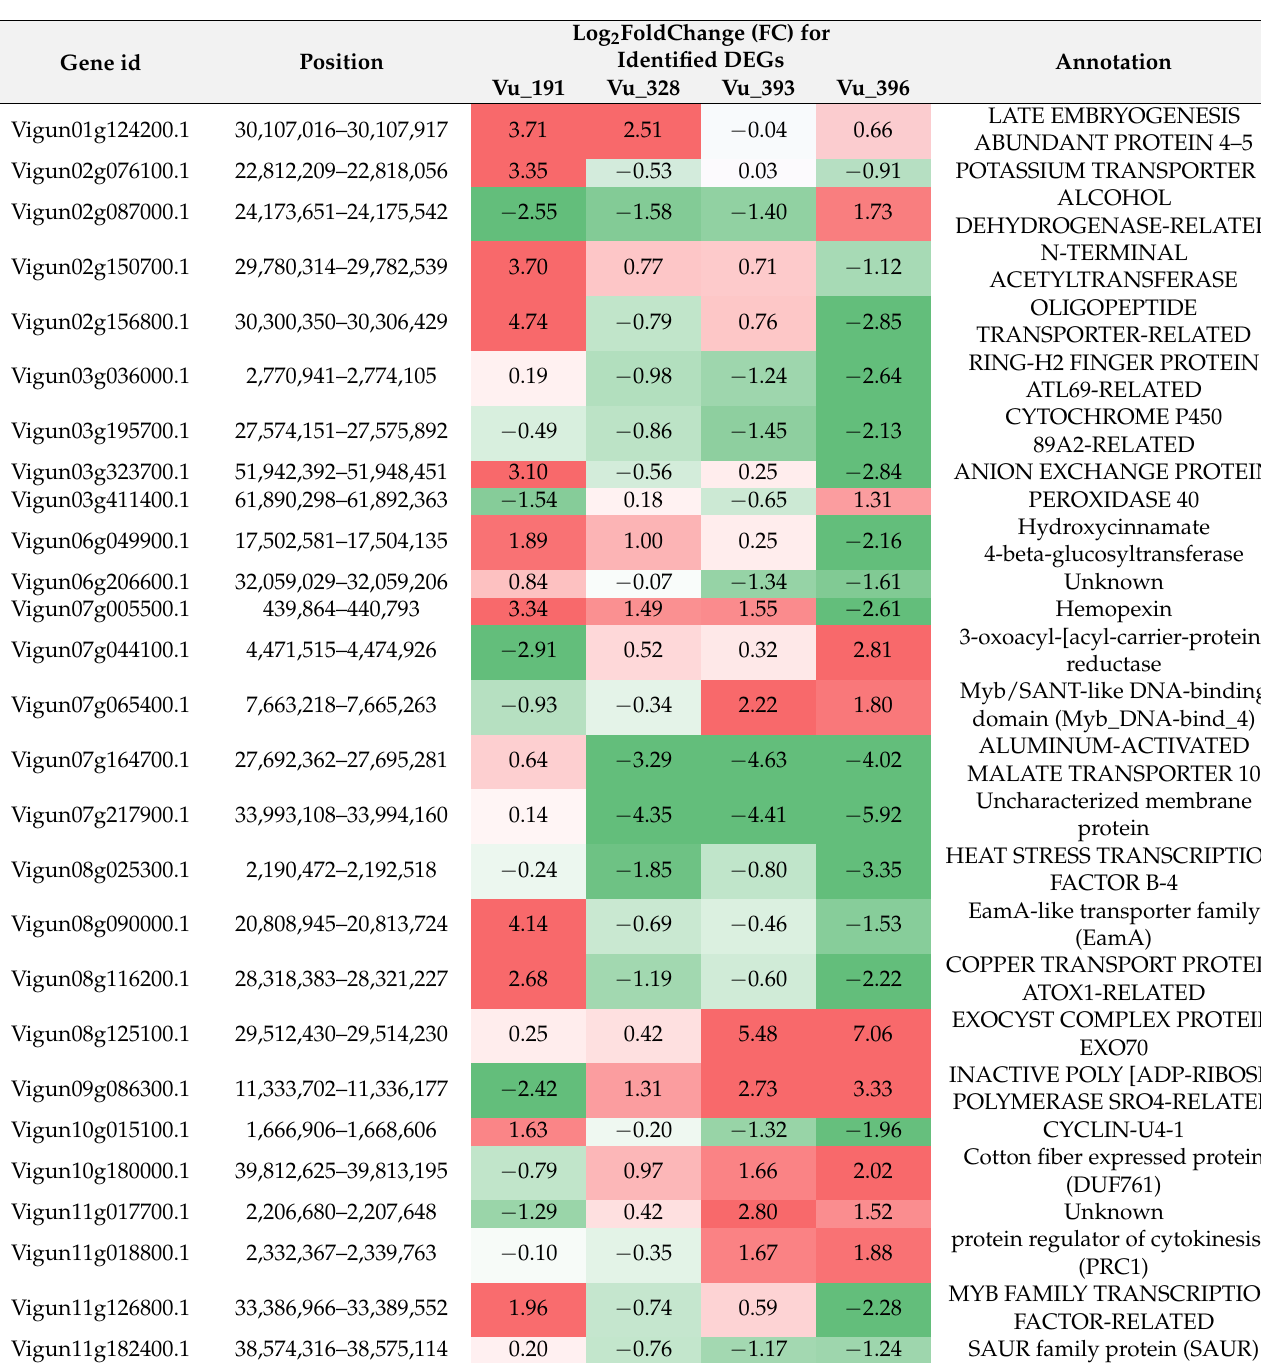
Table 1. Log 2 foldchange (FC) and functional annotations for differentially expressed genes (DEGs) with significant expression patterns. The color of background indicates the gene expression level from red (up-regulated) to green